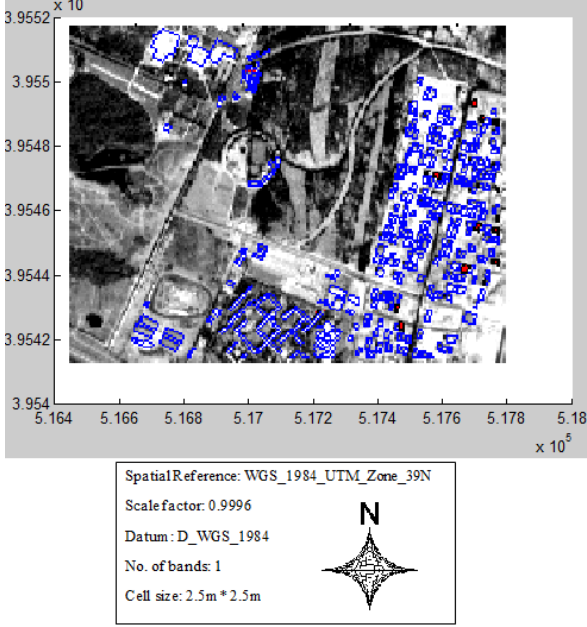
Figure 8. The detected changed building (Red